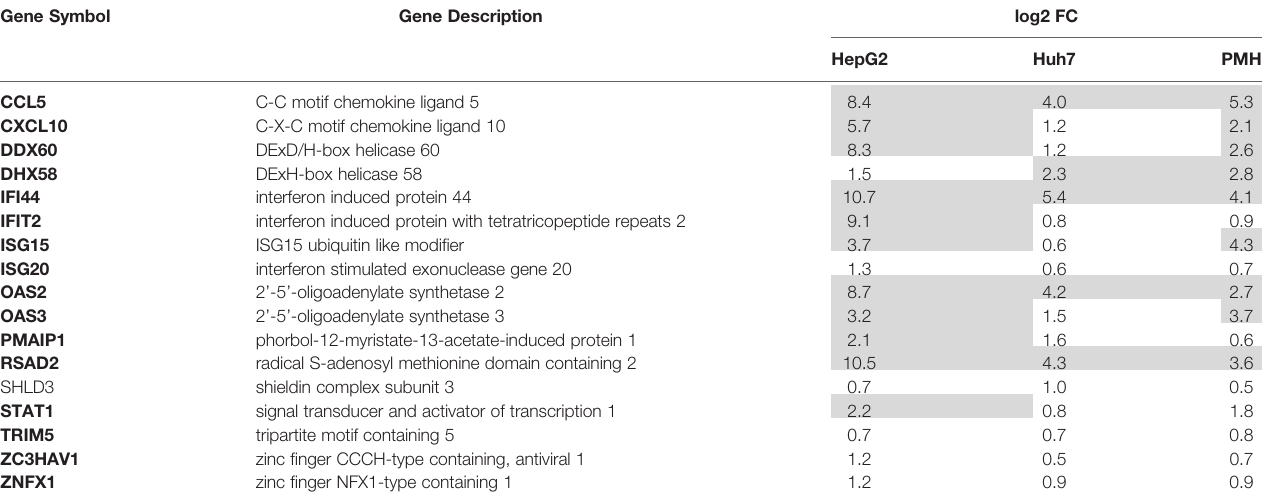
TABLE 1 | Seventeen genes are upregulated by long-term Listeria infection in all hepatocyte models. Gene Symbol Gene